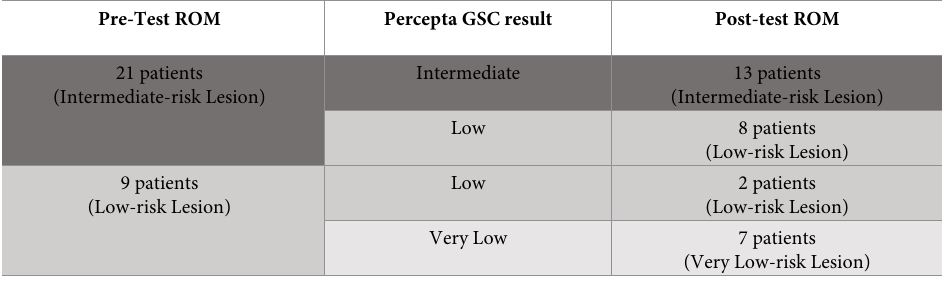
Table 3. Patients � with down-classified low- and intermediate-risk benign lesions who underwent additional inva- sive procedures.